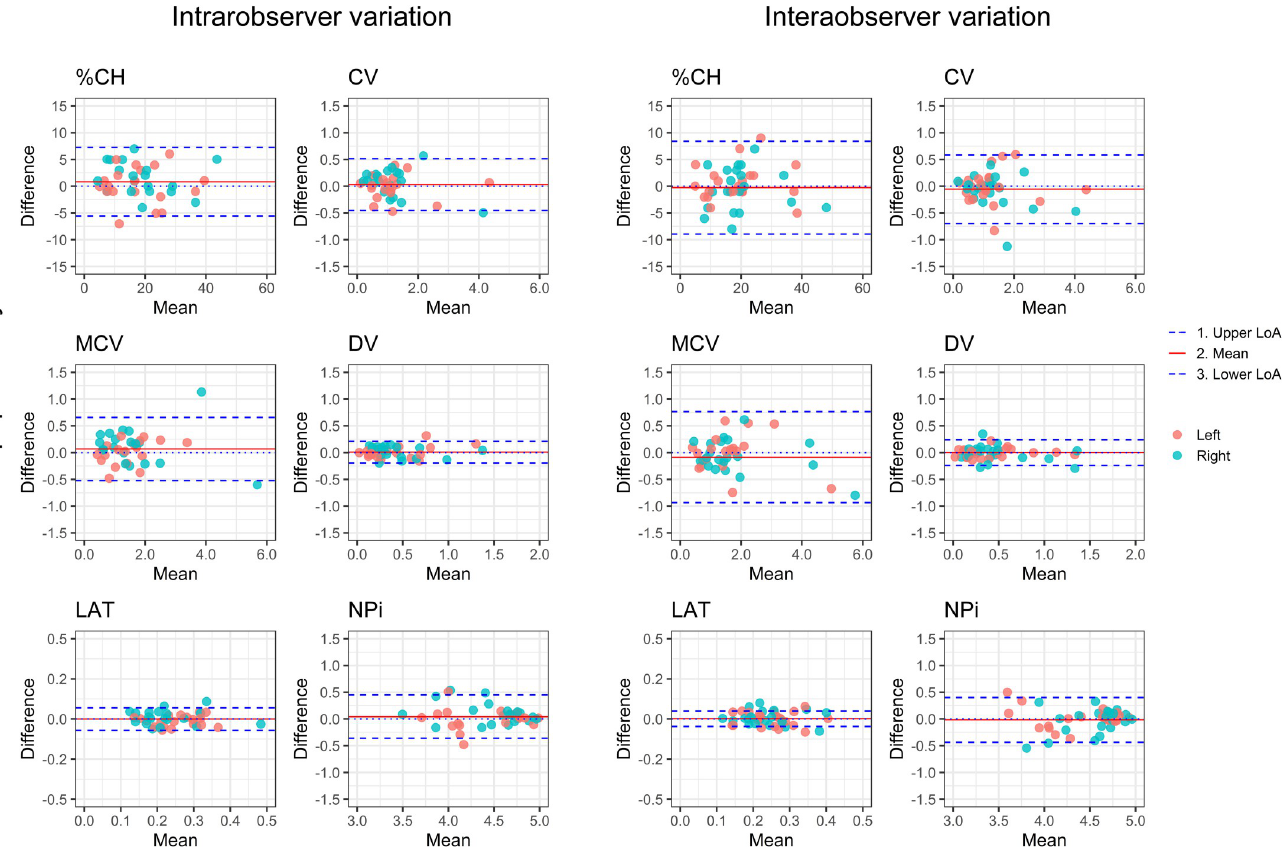
Fig 3. Additional quantitative pupillary response parameters. Bland Altman plots depicting intra-, and inter-observer variability of quantitative pupillary response parameter. %CH = percental change, CV = average constriction velocity, MCV = maximum constriction velocity, DV = dilation velocity, LAT = latency of constriction, NPi = Neurological Pupil index, LoA = limit of